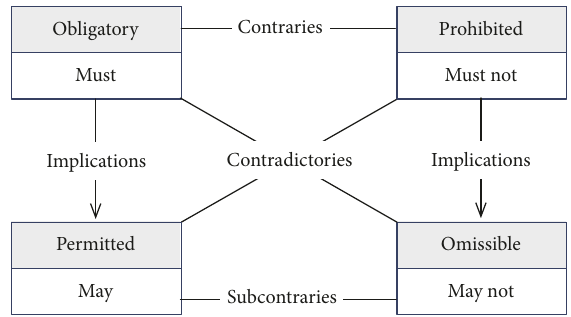
Figure 1: The deontic square of